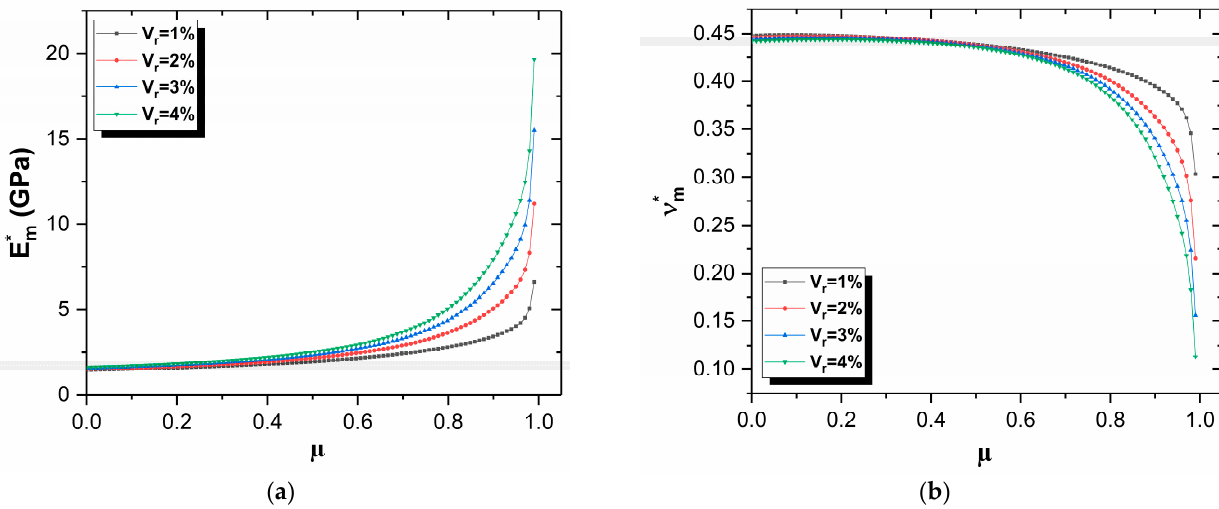
Figure 16. Effective elastic moduli of composite reinforced by randomly GNP inclusion in PP matrix, in function agglomeration (parameter µ at small volume fraction (1–4%): ( a ) effective Young’s modulus E ∗ m ; and ( b ) effective Poisson’s ratio ν ∗ m .